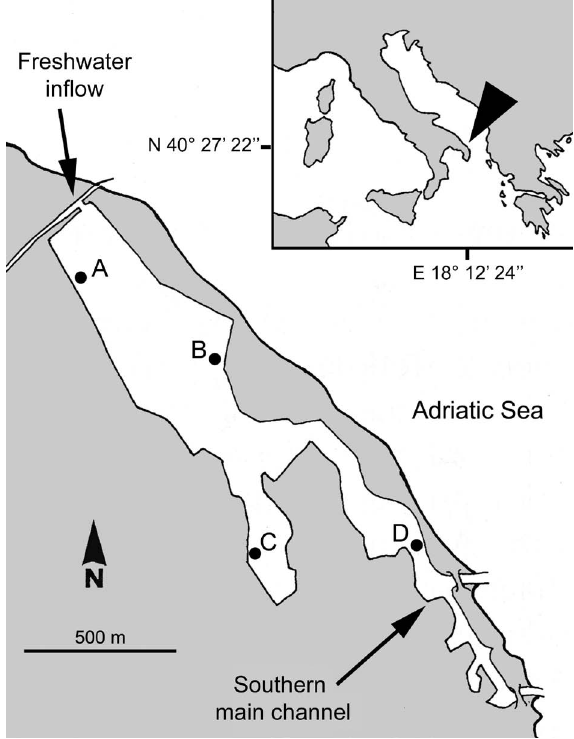
Fig . 1. – Map of the study area (modified from Giangrande and Fraschetti,